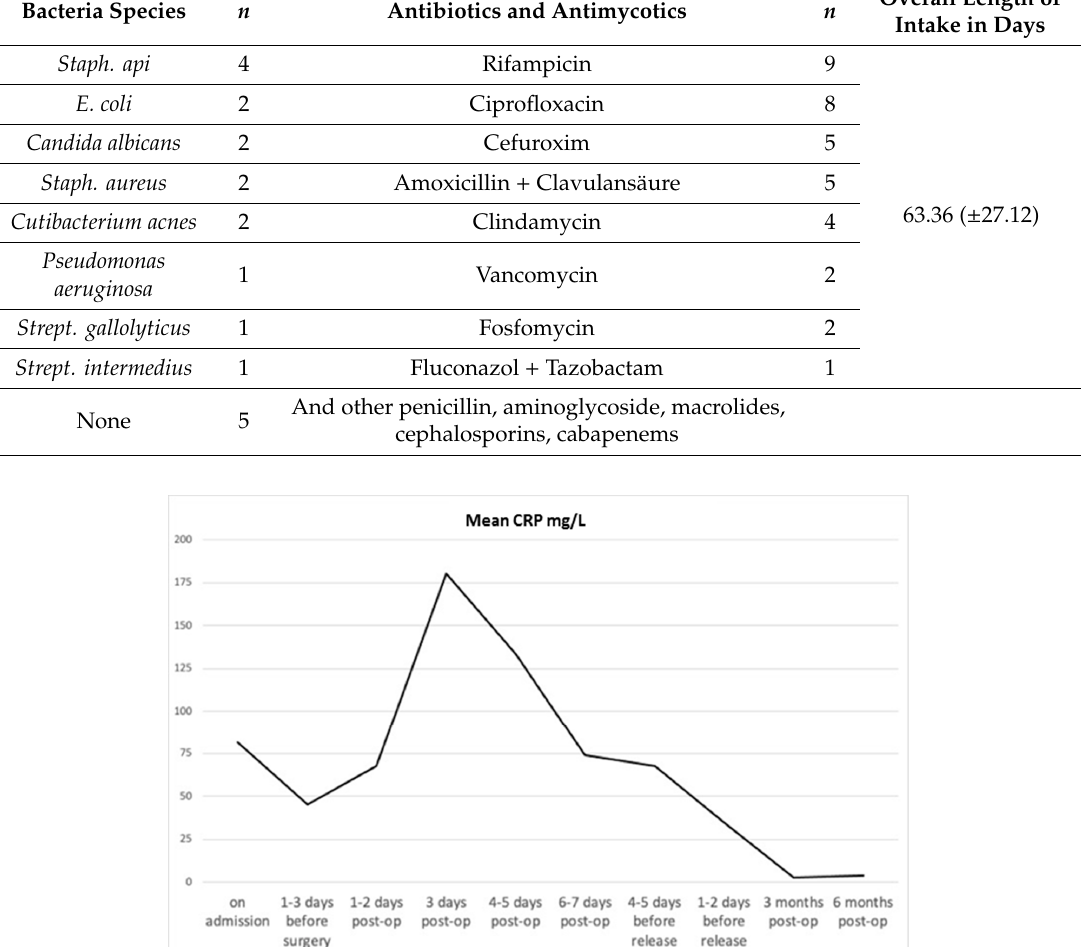
Table 3. Bacteria species detected in tissue samples and antibiotic therapy .